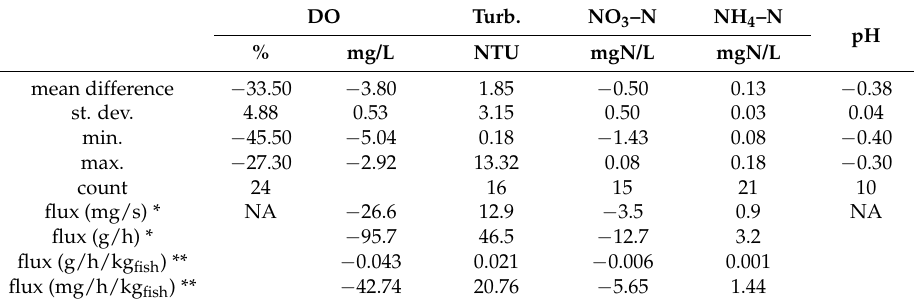
Table 4. Summary of the 1 15 pond differential data and fluxes between outlets and inlet. DO